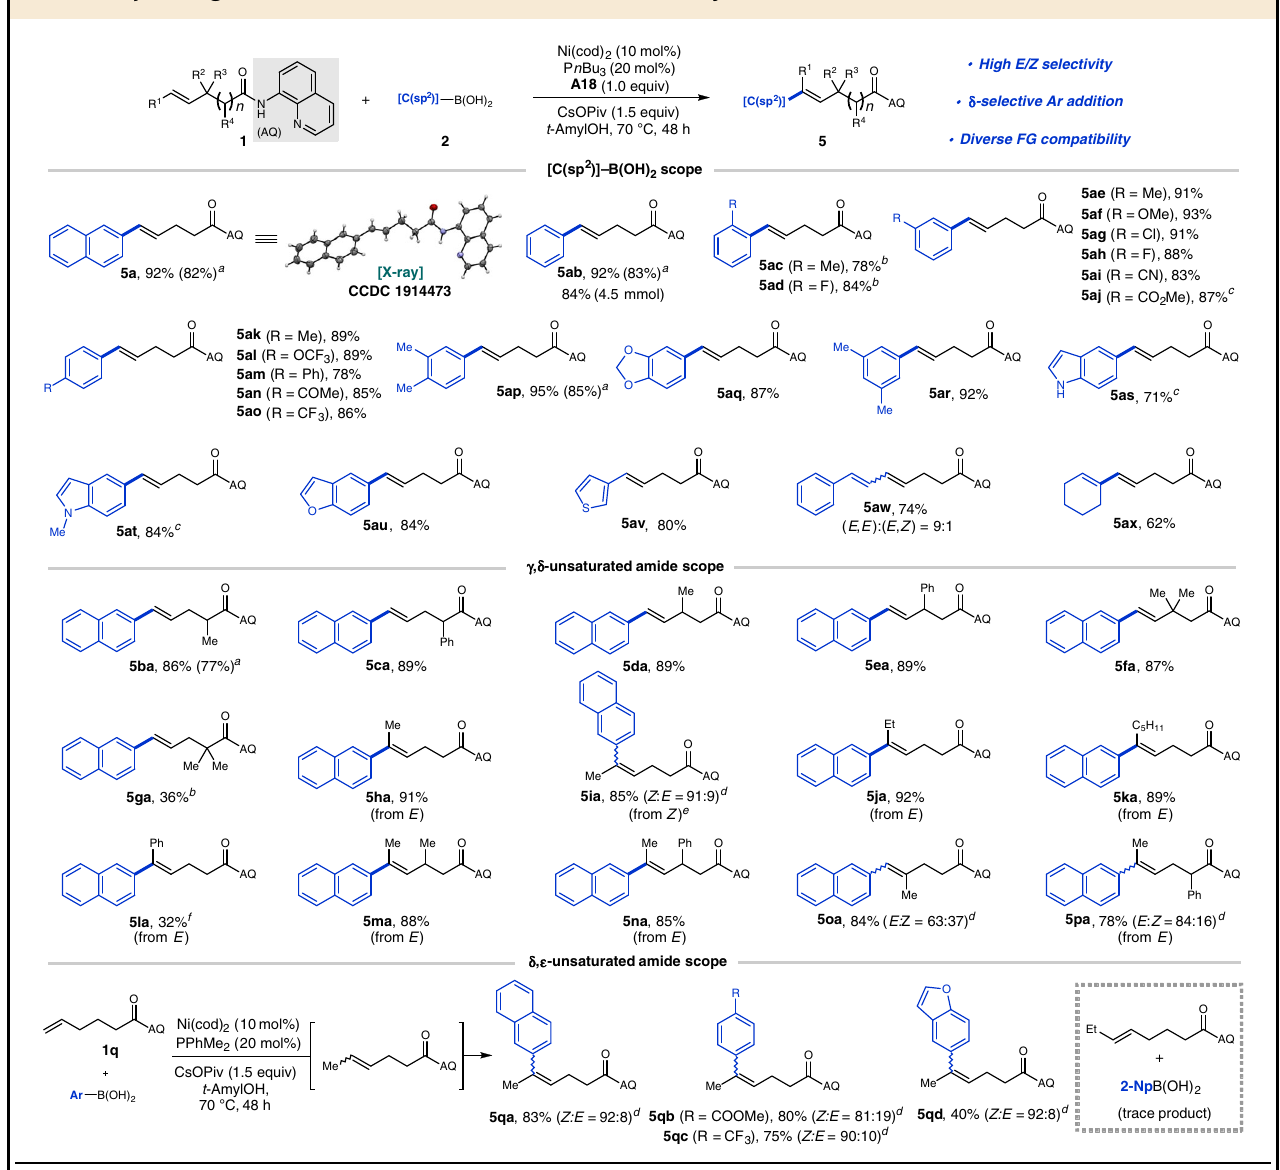
Table 3 Scope of organoboronic acids and alkenes in oxidative Heck